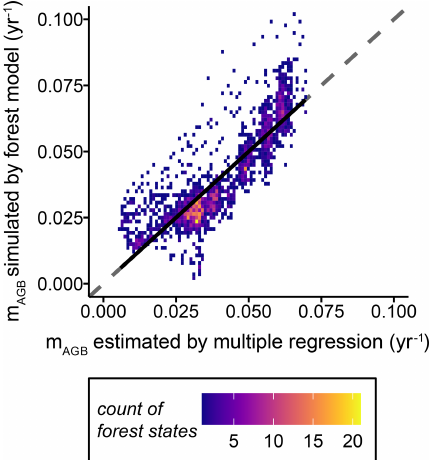
Figure 6. One-to-one density plot of biomass loss rates simulated by the dynamic forest model versus biomass loss rates estimated using a multiple linear regression model, with the forest height and leaf area index as proxy variables (Eq. 7 and Table S3). The dashed line shows the line of perfect fit. Each dot represents a forest stand with a unique forest structure (i.e. tree size distribu- tion and functional species composition), while the colours repre- sent the density distributions of the combinations. The black solid line indicates the mean deviation of the biomass loss rate simulated with the forest model from the estimated ones ( m AGB , DFM = 1 . 0 · m AGB , LM − 0 . 0 + ε , R 2 = 0 . 7312, RMSE = 0 . 009, p value < 0 . 01) ( m AGB : biomass loss